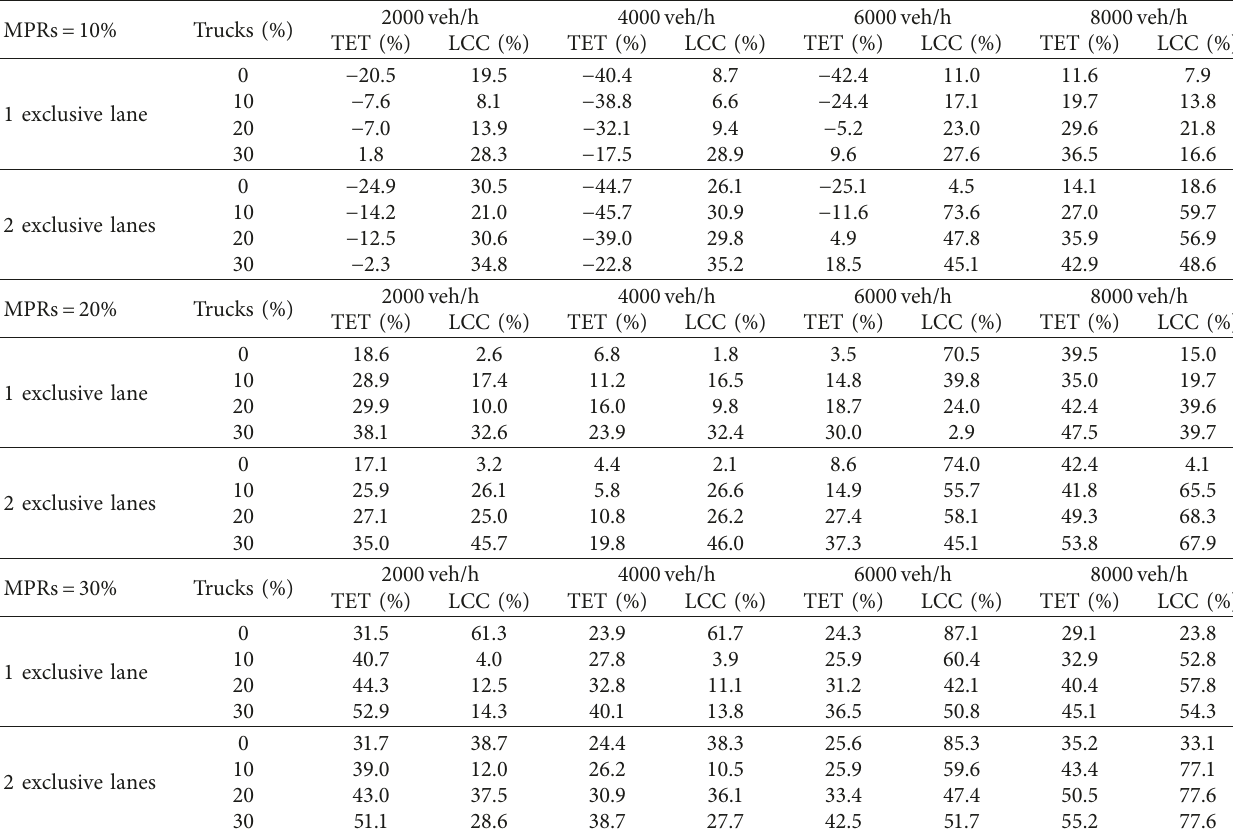
Table 4: Safety impacts of setting exclusive lanes compared with the base